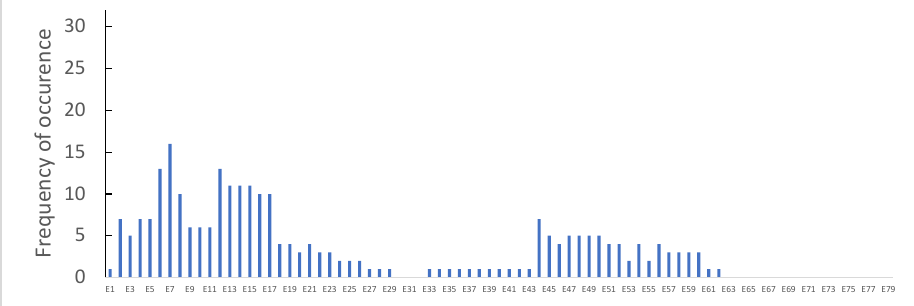
Fifty ‐ five DMD patients (11.8%) had large duplications, the largest of them involving 37 exons (E33–E60). Eighteen (32.7%) patients presented a single exon duplication, which